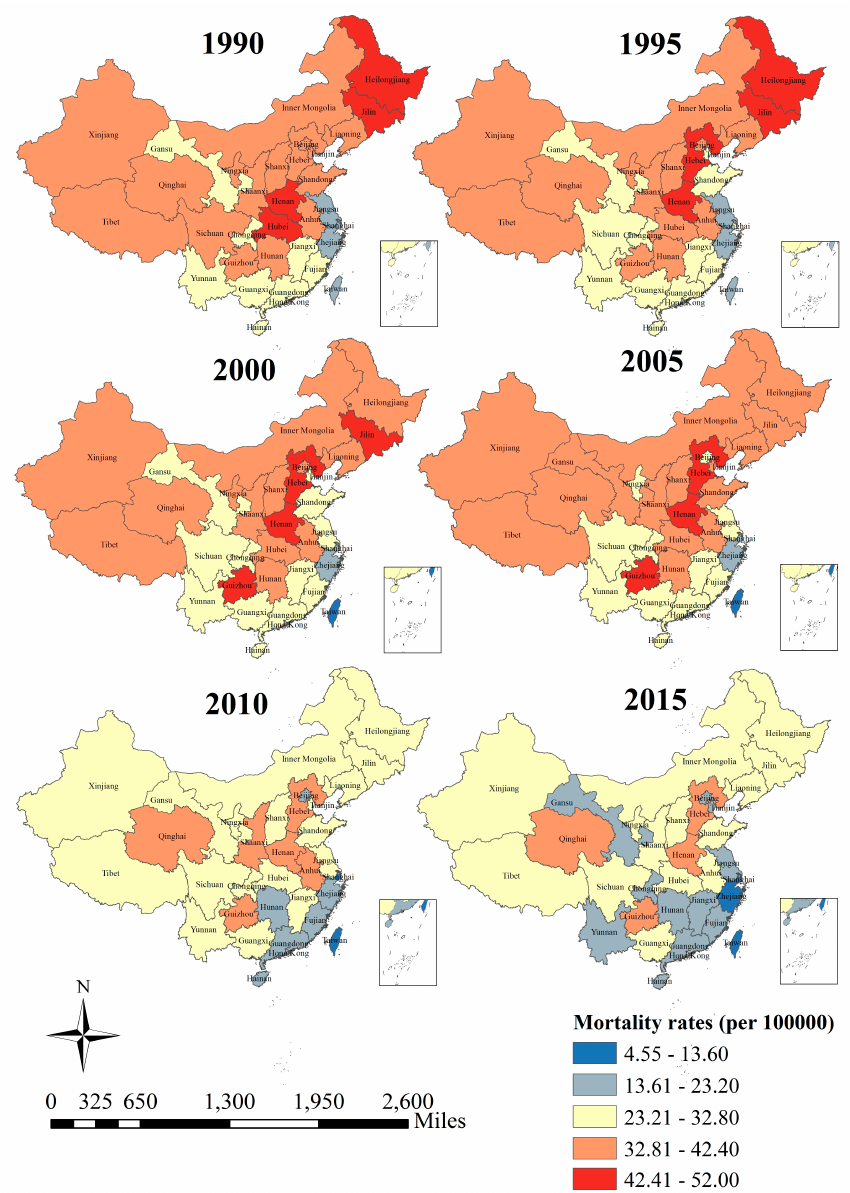
Figure 9. The description of stroke mortality-PM 2.5 by province in 1990–2015, China.